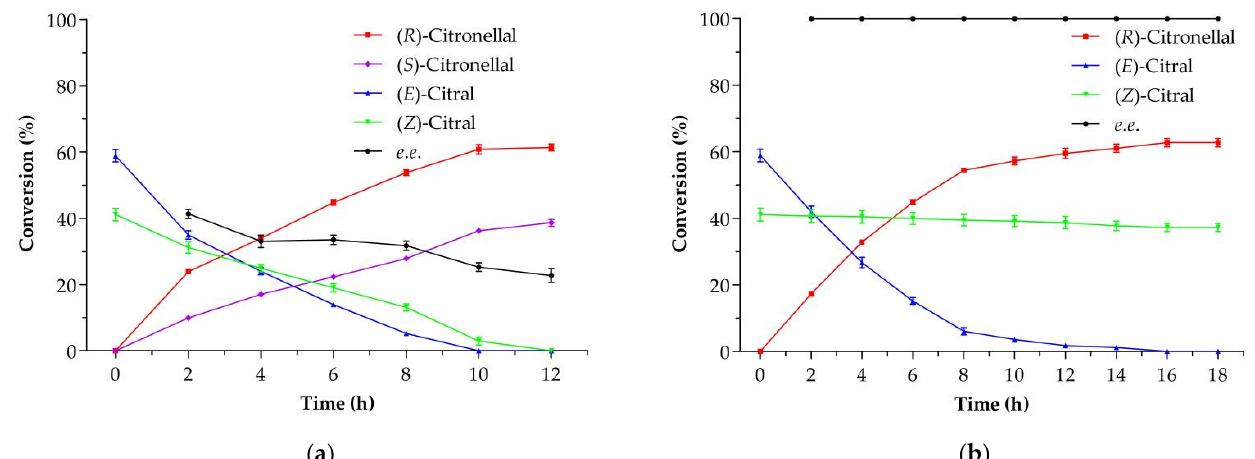
Figure 4. Time courses of asymmetric reduction of ( E/Z )-citral to ( R )-citronellal. ( a ) OYE3 and GDH as biocatalyst; ( b ) the variant OYE3 S296F/W116G and GDH as biocatalyst. The standard reaction mixture (10 mL) contained 20 mM ( E/Z )-citral, 0.4 mM NADP + , 0.15 U/mL GDH, 50 mM glucose, 0.15 U/mL of the variant S296F/W116G, and 50 mM PIPES buffer solution (pH 7.0). The stock solution of substrate was 200 mM citral dissolved in isopropanol. The reaction was conducted in a reactor with a pH auto-titration system at 400 rpm and 30 ◦ C for 12 h (OYE3) or 18 h (the variant S296F/W116G). Data present mean values ± SD from three independent experiments. ( E / Z )-citral contained 58.4% geranial and 41.6% neral.